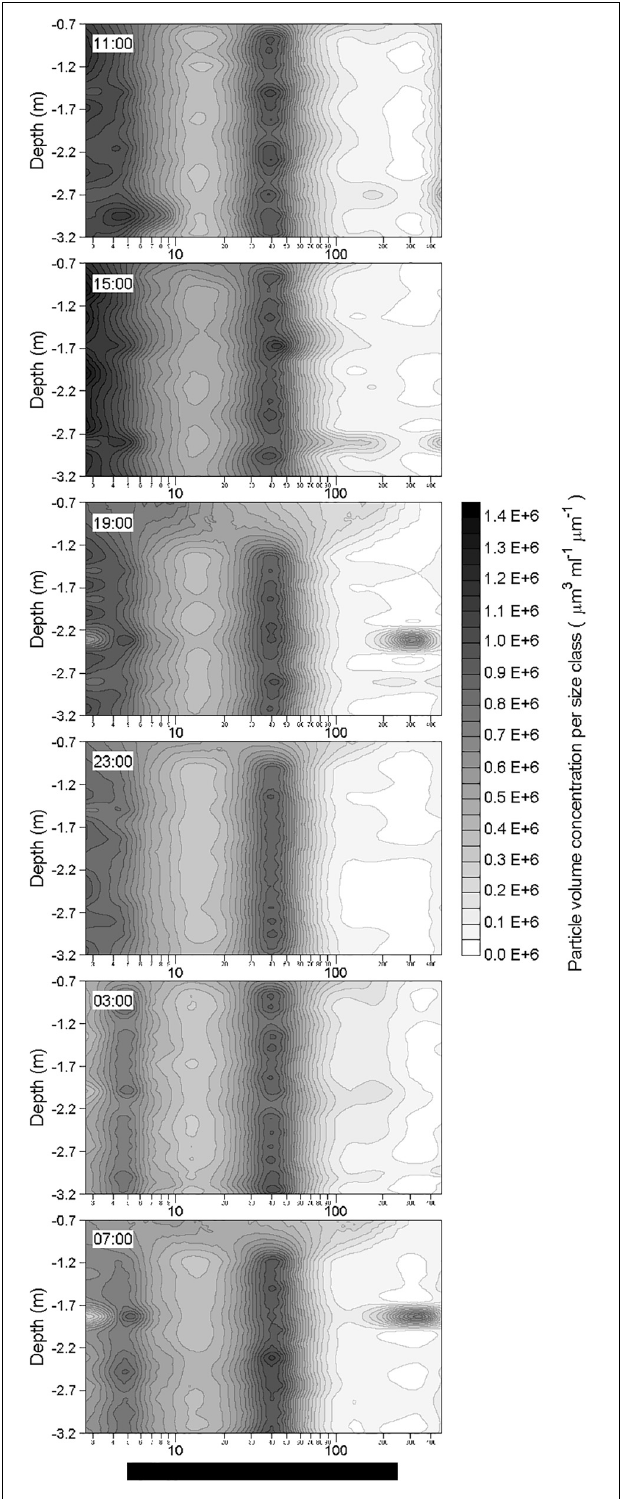
FIGURE 9 | Vertical distributions of in situ volume concentration of particles ( µ m 3 mL − 1 µ m − 1 ) as a function of their equivalent spherical diameter ( µ m) in the water column during the 24-h cycle. Each contour plot was obtained